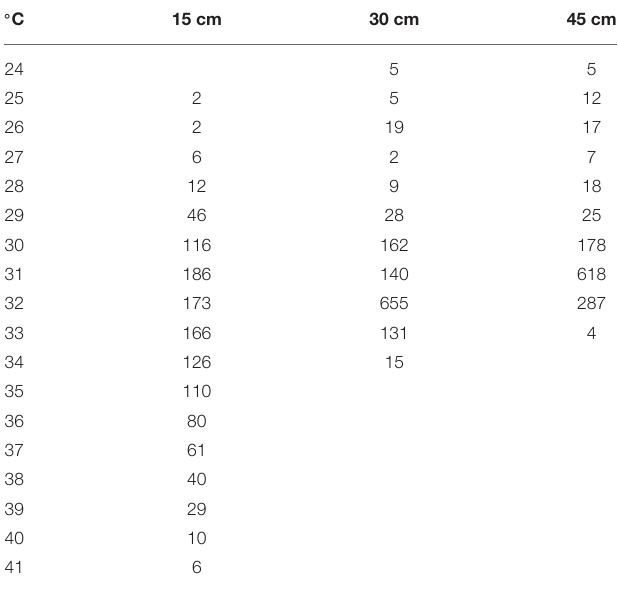
TABLE 2 | Number of hours accumulated during 7 weeks of biodisinfestation treatment at different temperatures and at the different soil depths (15, 30, and 45cm) in the treated